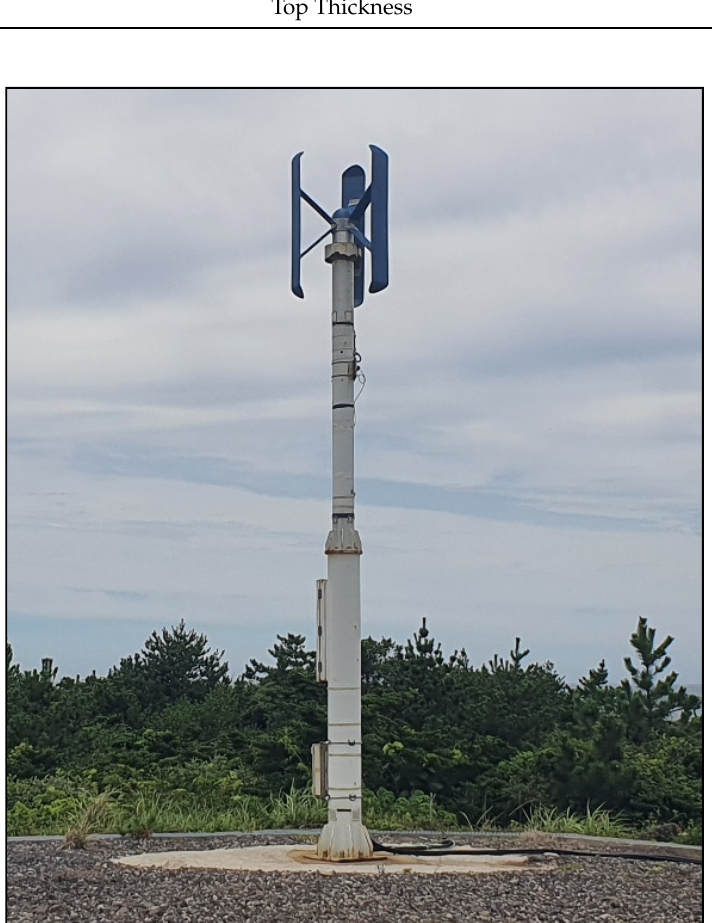
Figure 1. Small H-type Darrieus VAWT at the experimental site in Jeju Island, South Korea. Table 1. Small H-type Darrieus VAWT configuration [24].